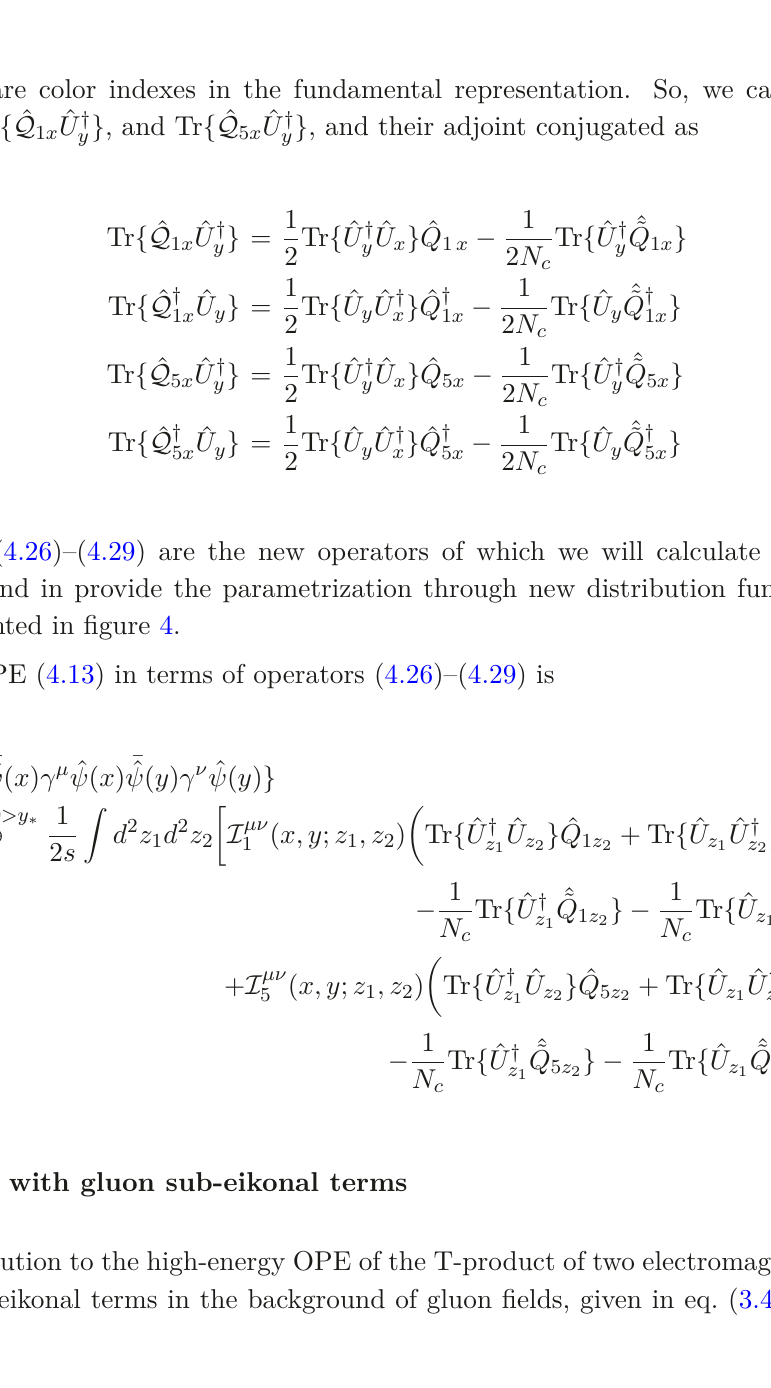
} Q 1 x , and Tr { U x U † y } y